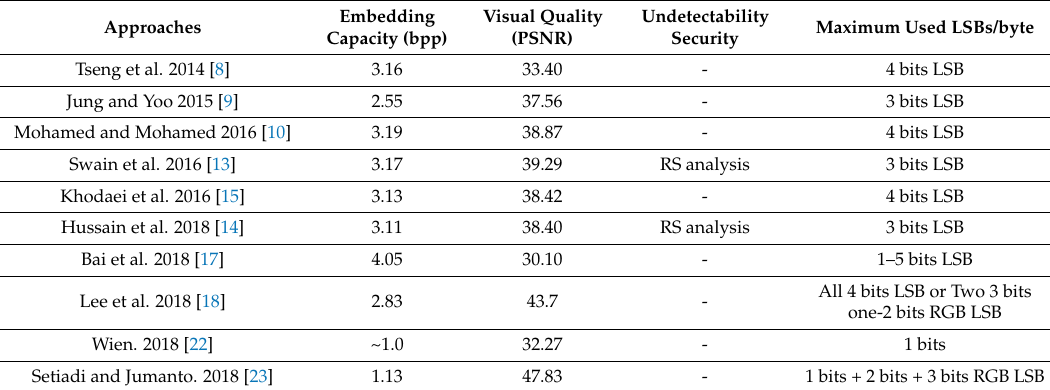
Table 1. General performance comparison of existing methods, PSNR: peak signal to noise